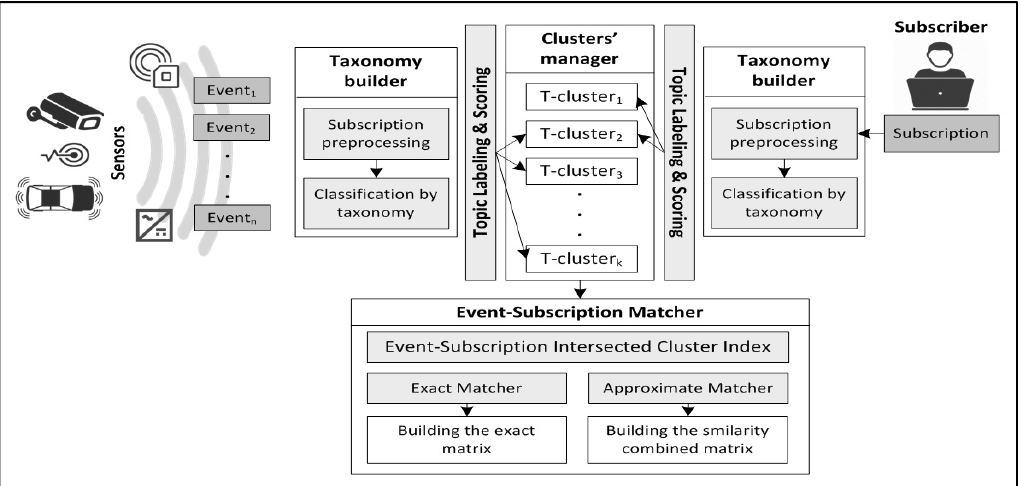
Figure 1. Architecture of the event matching system.